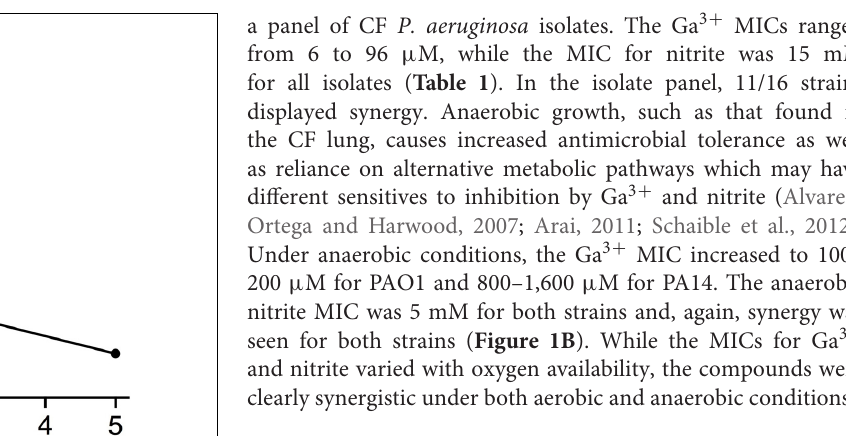
Frontiers in Microbiology |